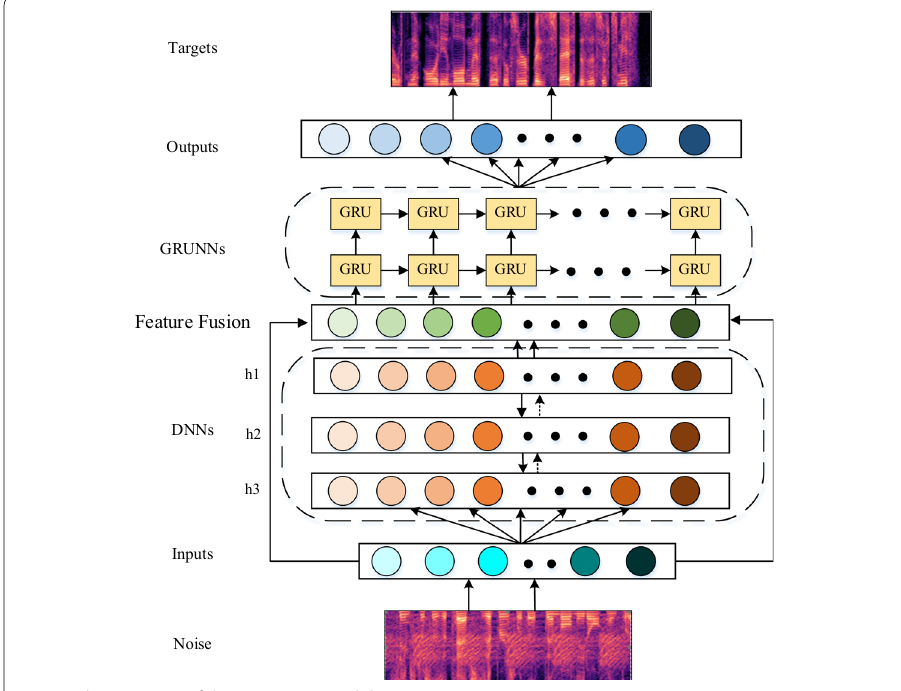
Fig. 5 The structure of the DNN-GRU